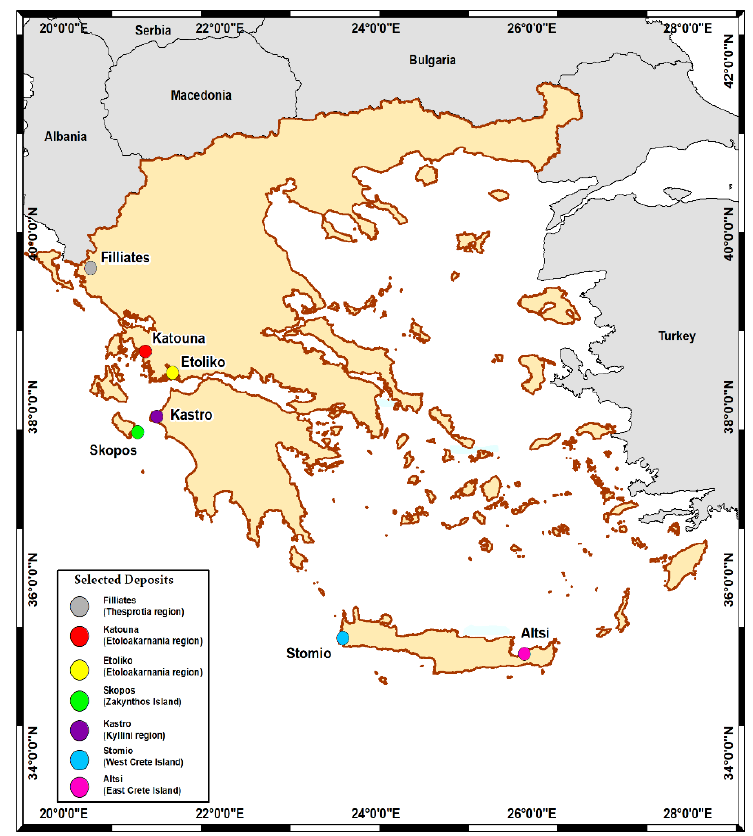
Figure 1. Map of Greece indicating the sample localities.